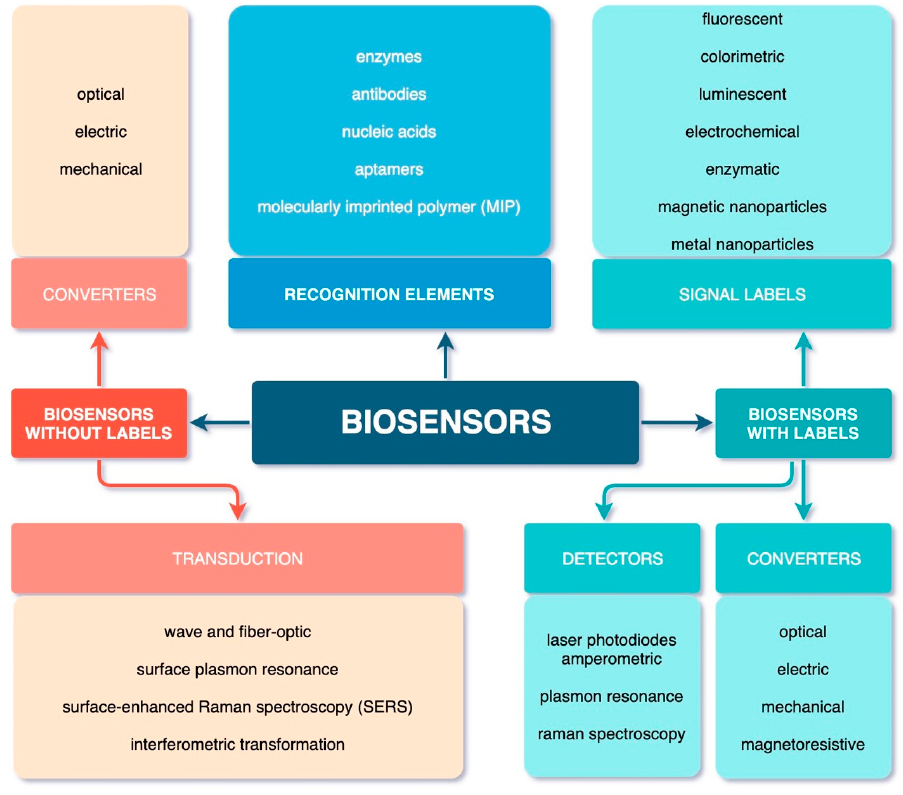
Figure 3. Classification of biosensors based on constructive strategies for detection methods.